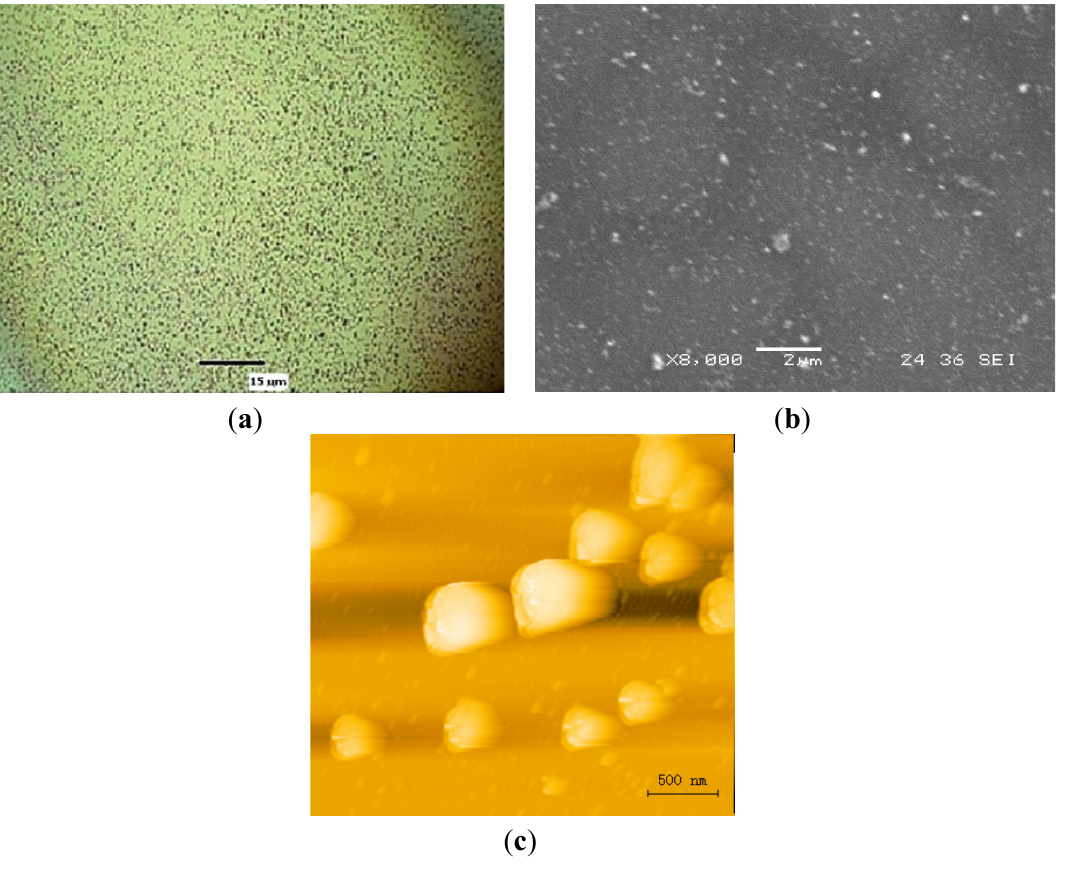
Figure 4. Gold nanoparticles on the surface of silicon substrate (setup 5). ( a ) Optical image, ( b ) SEM image and ( c ) AFM image.